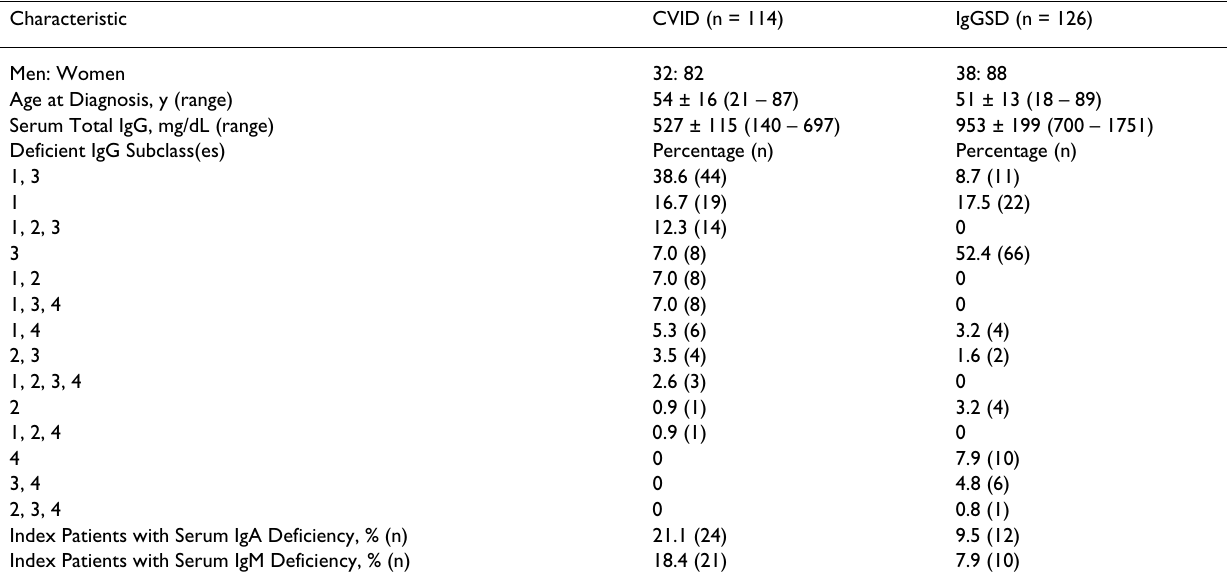
Table 1: Characteristics of Index Patients with CVID and IgGSD. 1